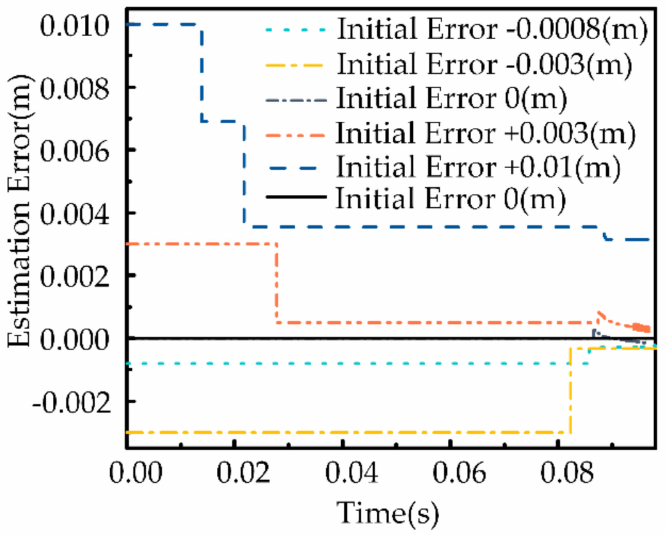
Figure 9. Estimation error of the target position of the uncertain object.